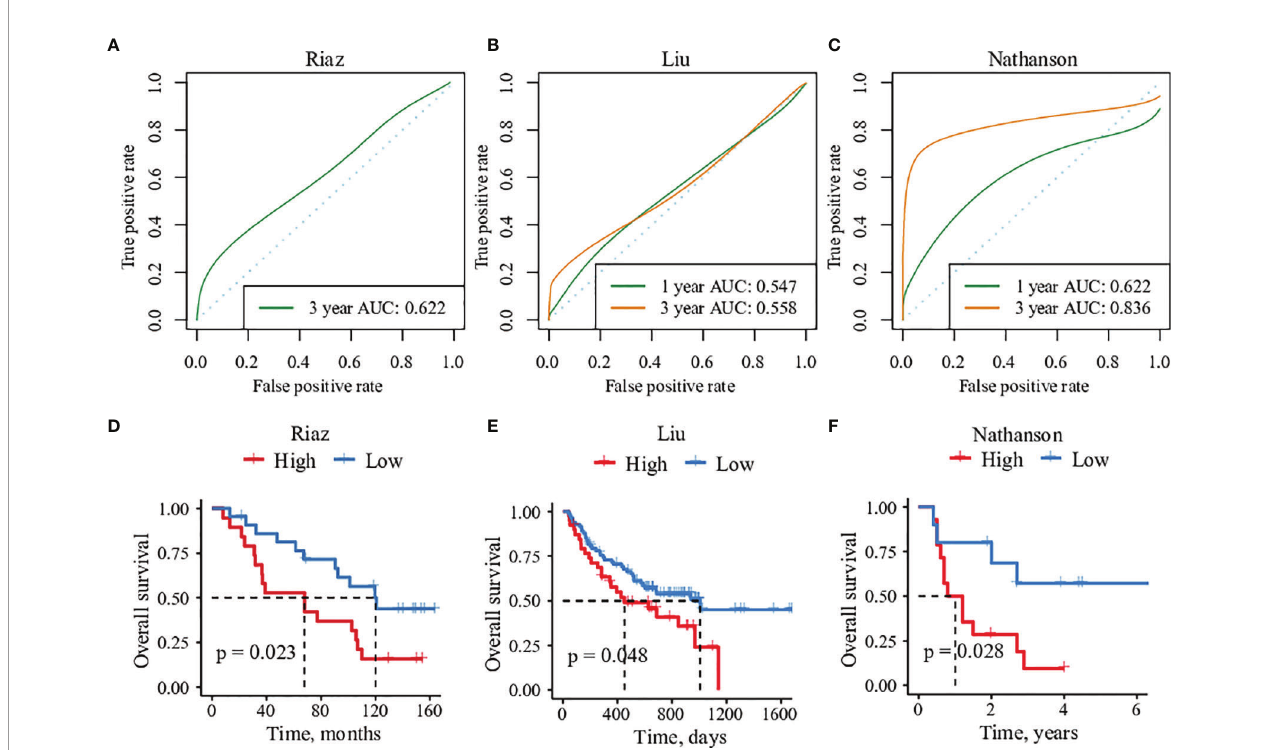
FIGURE 4 | The predictive ef fi cacy of 15 immune-related genes risk score in three validation cohorts. (A – C) Sensitivity and speci fi city of the risk score model were assessed in each dataset by time-dependent ROC analysis. (D – F) Overall survival analysis between high- and low-risk groups in each